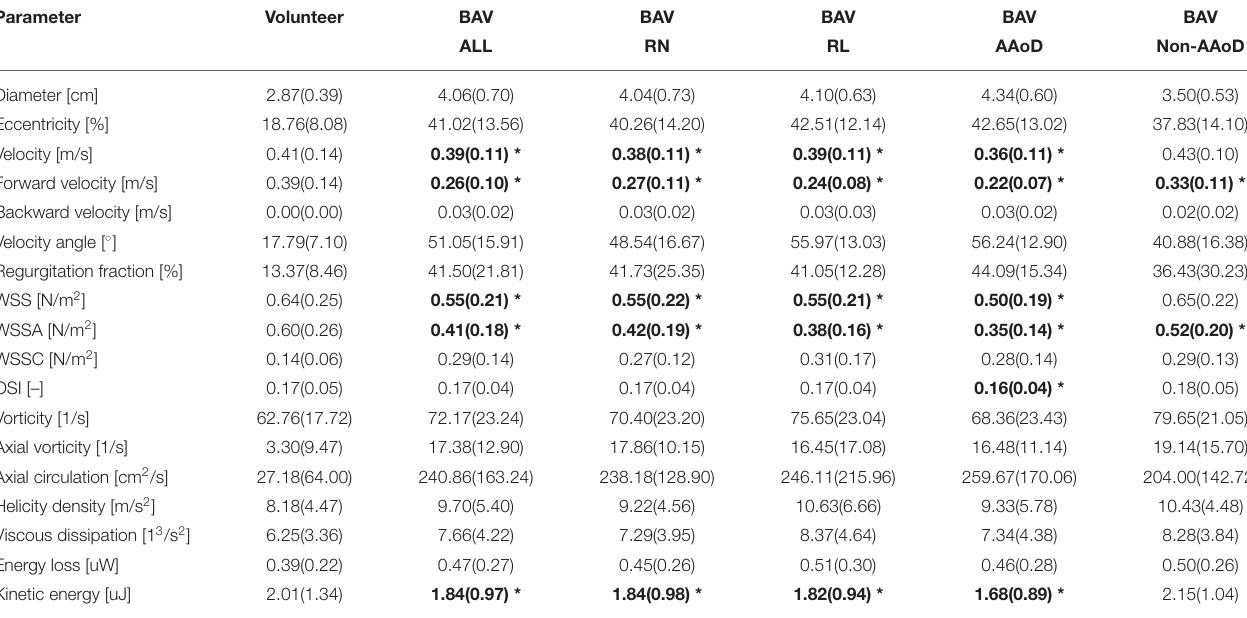
TABLE 2 | Mean and (standard deviation) for each parameter in the AAo section (regions 1 to 4).